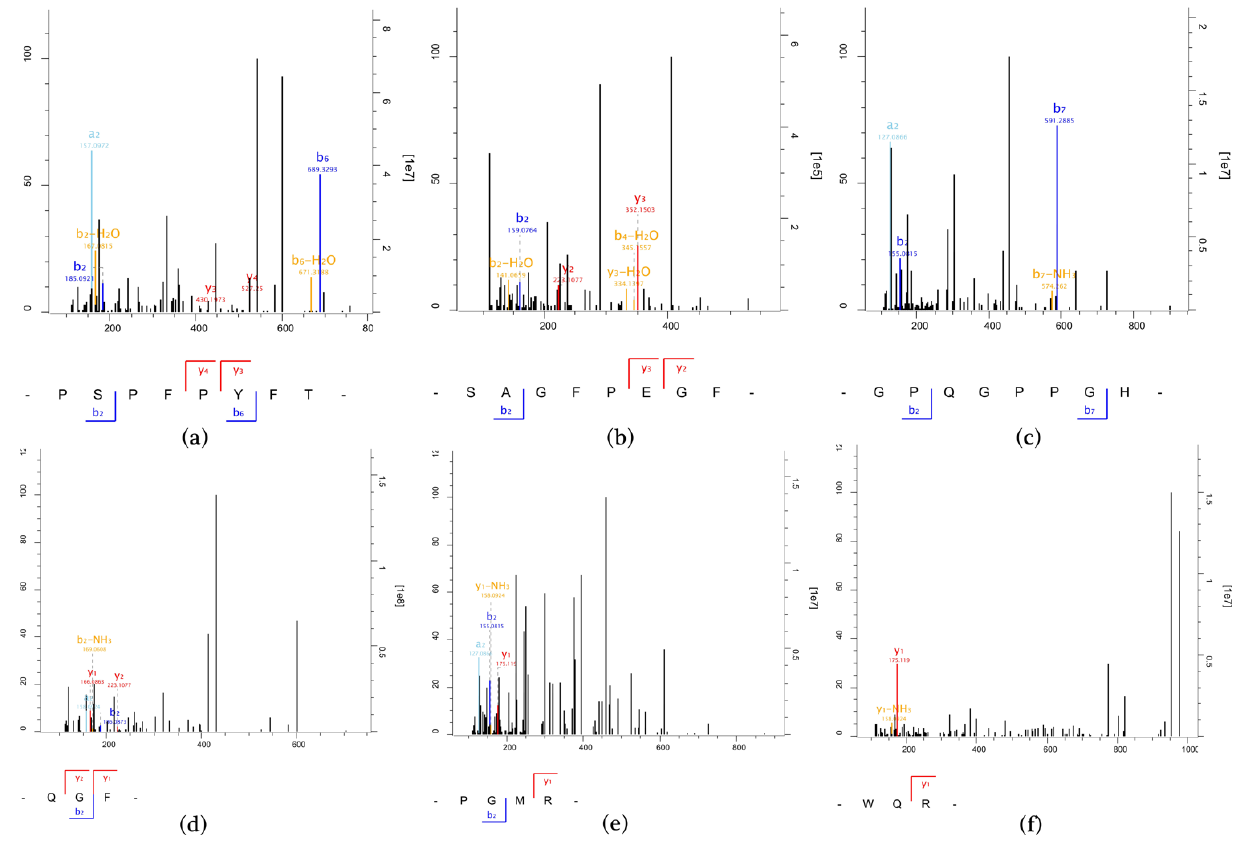
Figure 4. MS/MS spectra of six immunomodulatory peptides identified and screened from the M4-1 fraction PSPFPYFT ( a ), SAGFPEGF ( b ), GPQGPPGH ( c ), QGF ( d ), PGMR ( e ), and WQR ( f ).